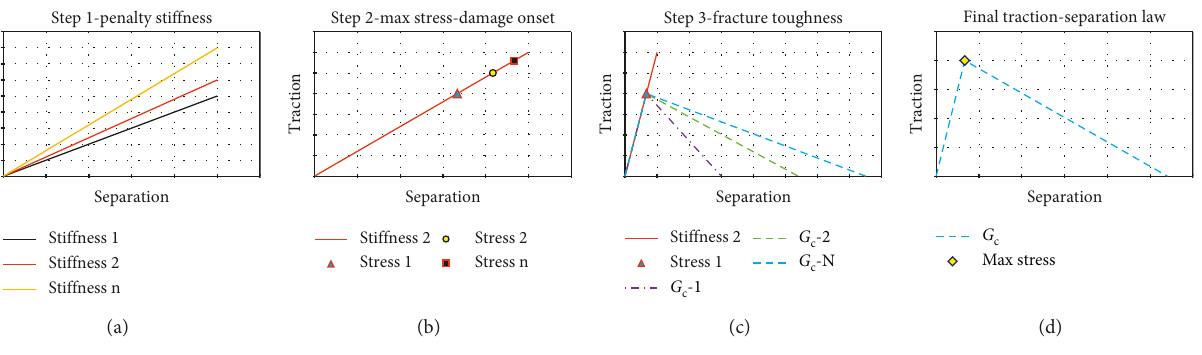
Figure 2: Definition of traction-separation law, step by step. Table 1: Material properties for 3PB test.